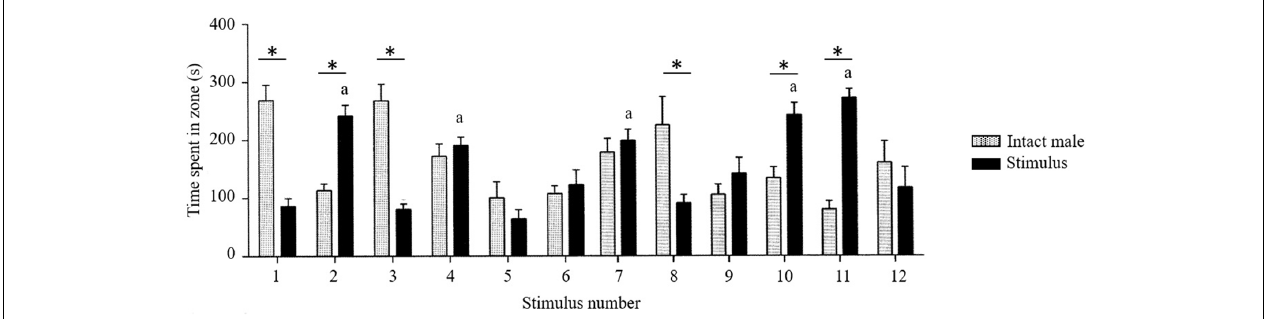
FIGURE 8 | Sexual approach behavior in male rats in response to different kinds of stimuli (black bars). As control for social approach, an intact male was used (gray bars). The experimental subject could choose between spending its time close to the male stimulus or close to the alternative stimulus. The ordinate shows time spent in proximity to the different stimuli. The stimuli are indicated on the abscissa. 1. An intact male and an empty, clean cage, N = 11. The time spent close to the male was far superior to the time spent close to the empty cage. This illustrates nicely the male’s social attraction. 2. An intact male and a sexually receptive female, N = 10. The difference between the time spent with the female and the time spent with the male is the intensity of sexual attraction [(sexual + social approach) – social approach] = sexual approach. 3. Intact male and playback of female ultrasonic vocalizations, N = 10. As can be seen, the vocalizations were not more attractive than a silent, empty cage. 4. Intact male and the odor of a sexually receptive female, N = 11. The female had spent 6 h in the cage before being removed just before the test. She left behind urine, feces and other body odors that may stick to the floor and walls of the small cage. The odor was not more attractive than the male. Thus, odor by itself has no sexual attractant properties according to our definition (see Stimulus 2). 5. As always, an intact male. The other stimulus was here an anesthetized female and the experimental subject was anosmic. Thus, the only stimulus modality available to the male was vision, N = 9. Neither of the stimuli was more attractive than an empty cage. Thus, olfaction is necessary for social as well as for sexual approach. Visual stimuli have no impact. 6. Intact male and a devocalized female were the available stimuli, and the experimental subject was anosmic. The test was performed in complete darkness. Thus, neither visual nor olfactory stimuli were available, and no stimuli from the female’s vocal cords, N = 10. None of the stimuli was attractive to the experimental male. 7. Intact male and the odor of a female + playback of female ultrasonic vocalizations were the alternatives, N = 10. Both were equally attractive, showing that odor + vocalizations have no sexual attractant properties. 8. Intact male and anesthetized female + playback of vocalizations. The experimental subject was anosmic, N = 9. There was no difference between these latter stimuli and an empty cage, showing that the sight and vocalizations from a female does not attract a male at all. 9. Intact male and sexually receptive female. The experimental subject was anosmic, and the test was performed in complete darkness. The only stimulus available to the male was auditory, N = 10. They did not produce sexual attraction. 10. Intact male and anesthetized female, providing olfactory and visual stimulation but no sounds, N = 11. She was as attractive as an active female. 11. Intact male and devocalized female, test performed in complete darkness, N = 9. This female was as attractive as an intact female. 12. Intact male and devocalized female. The subject was anosmic, N = 10. No social or sexual attractivity was observed. ∗ Different from the social incentive (male rat), p < 0.05. a Different from the empty cage (stimulus 1), p < 0.05. The conclusion from this experiment was that olfactory stimuli need to be combined with some other stimulus in order to activate sexual attraction. The other stimulus cannot be produced by the female’s vocal cords. Further details can be found in Ågmo and Snoeren